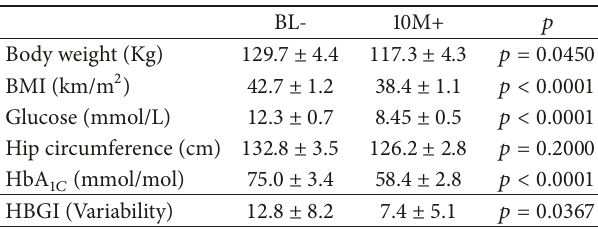
Table 1: Main characteristics and parameters of the complete database (Mean ± STD). Original results are taken from [13]. BL- 10M+